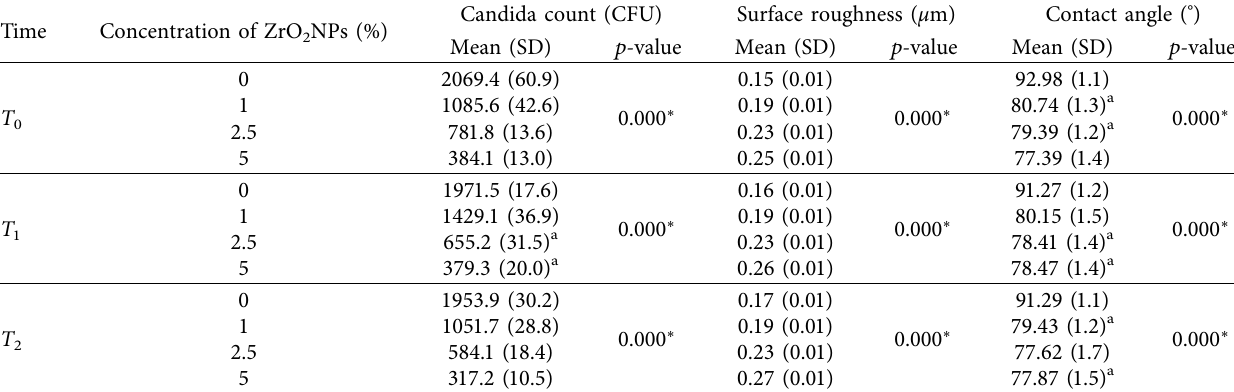
Table 1: Means, standard deviations, and p -values for heat-polymerized specimens modified with different concentrations of ZrO according to